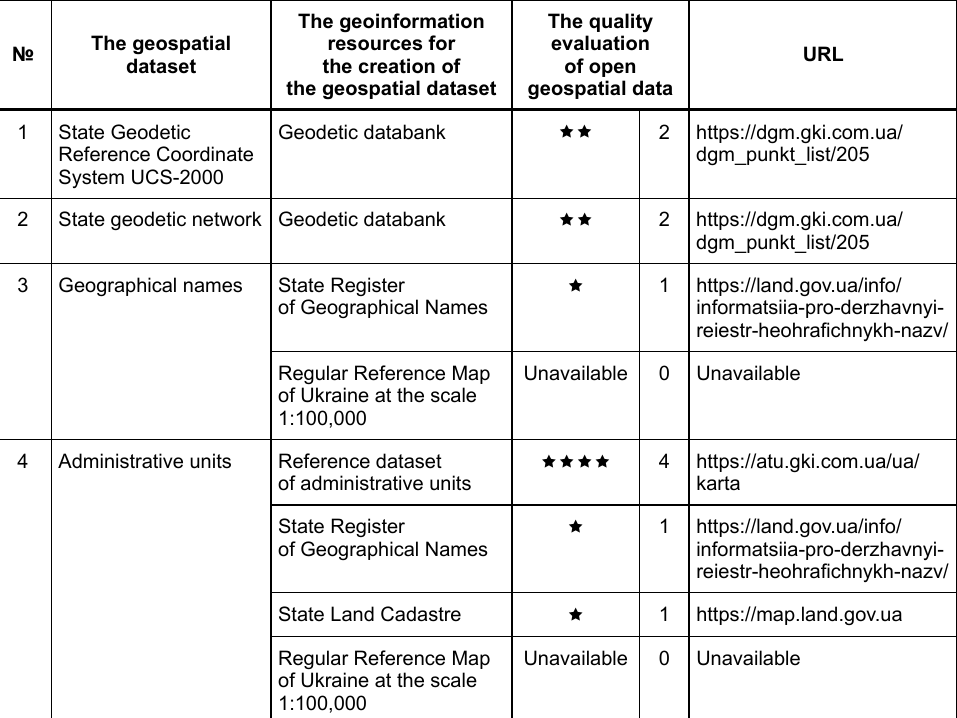
Table 2. The example of evaluation of open geoinformation resources for the creation of the geospatial